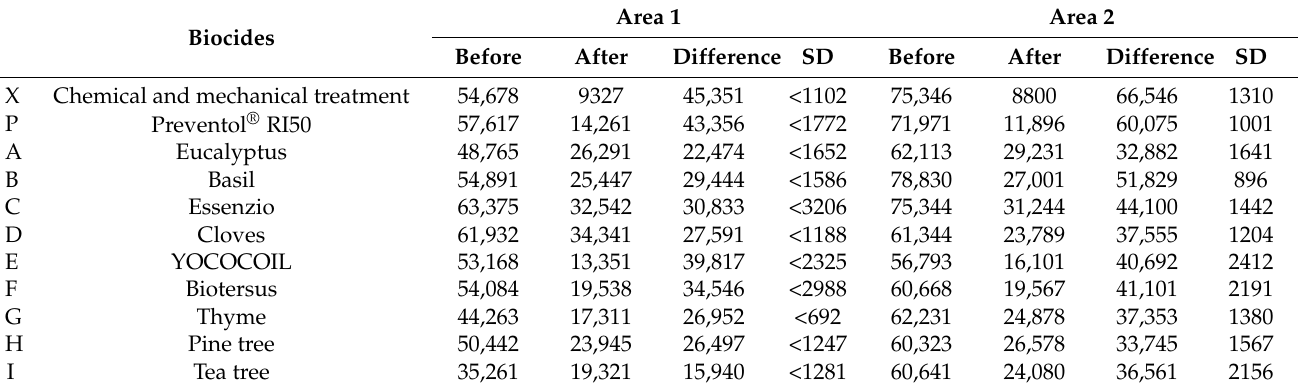
Table 6. Bioluminometric measures of ATP for each zone of Area 1 and Area 2.